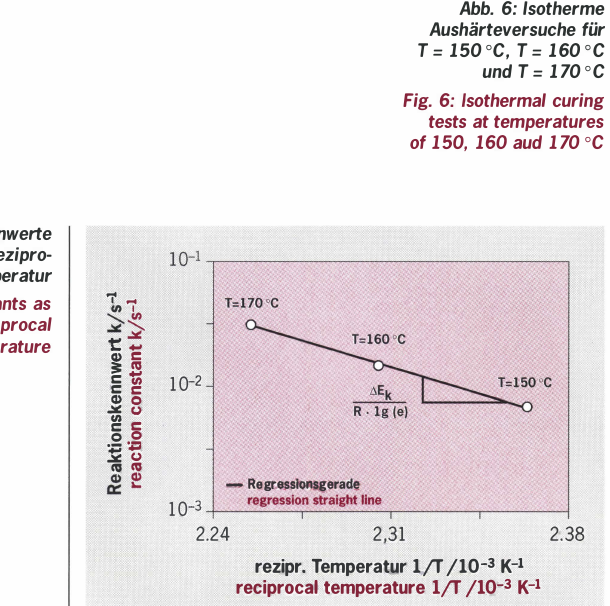
Fig. 6: Isothermal curing tests at temperatures of 150, 160 aud 170 o